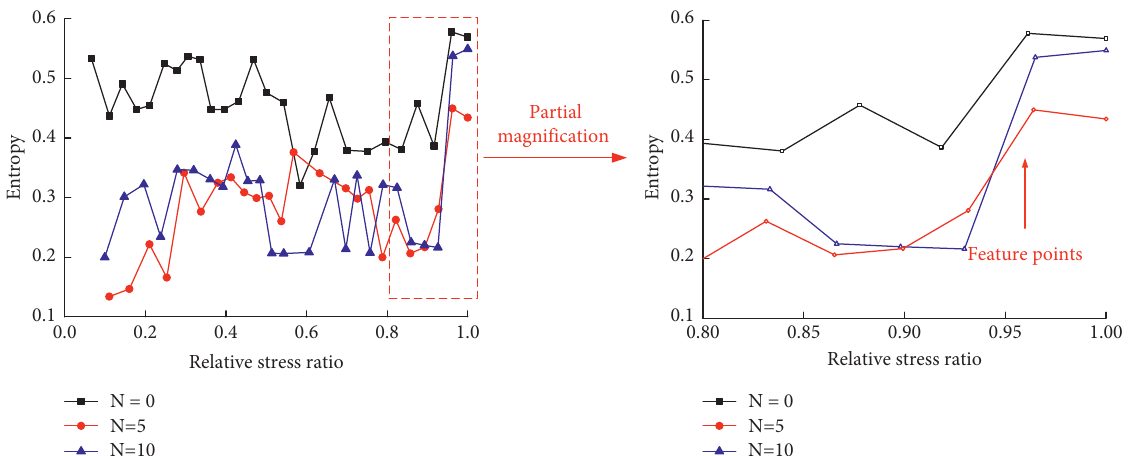
Figure 16: The change in the entropy value of the weakly cemented sandstone under different dry-wet cycles.